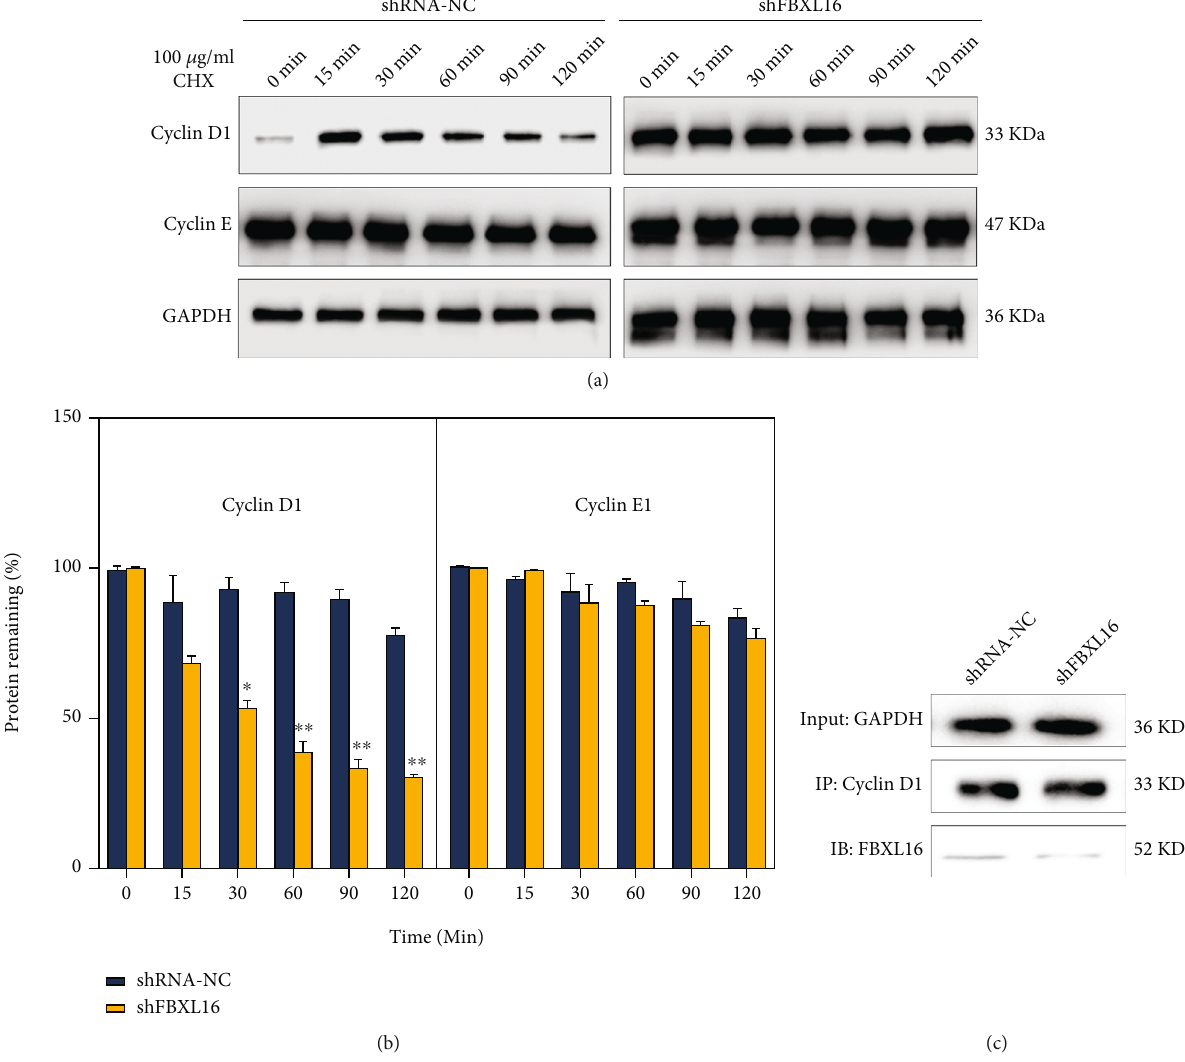
Figure 3: FBXL16 stabilized cyclin D1 protein by indirect interactions. (a, b) Ishikawa/MPA cells with shRNA-NC or shFBXL16 were pretreated with CHX for 90min, and protein expression of cyclin D1 and cyclin E was analyzed by western blot at indicated times (left) and quantitatively analyzed (right). (c) Coimmunoprecipitation of FBXL16 and cyclin D1 in Ishikawa/MPA cells with the shRNA-NC or shFBXL16 group. Results are presented as mean ± SD . ∗ P < 0 : 05 . ∗∗ P < 0 : 01 . ∗∗∗ P < 0 : 001